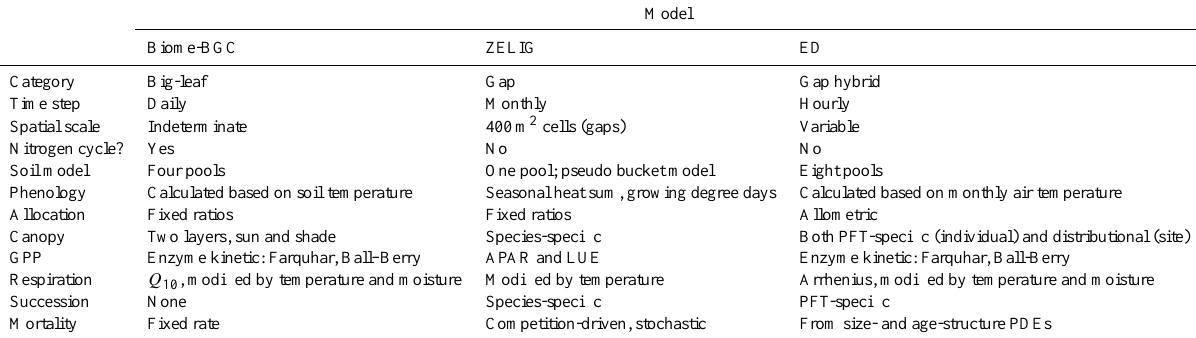
Table 1. Comparison of the models used in this study. LUE stands for light use efficiency, APAR stands for absorbed photosynthetically active radiation, and PFT stands for plant functional type.